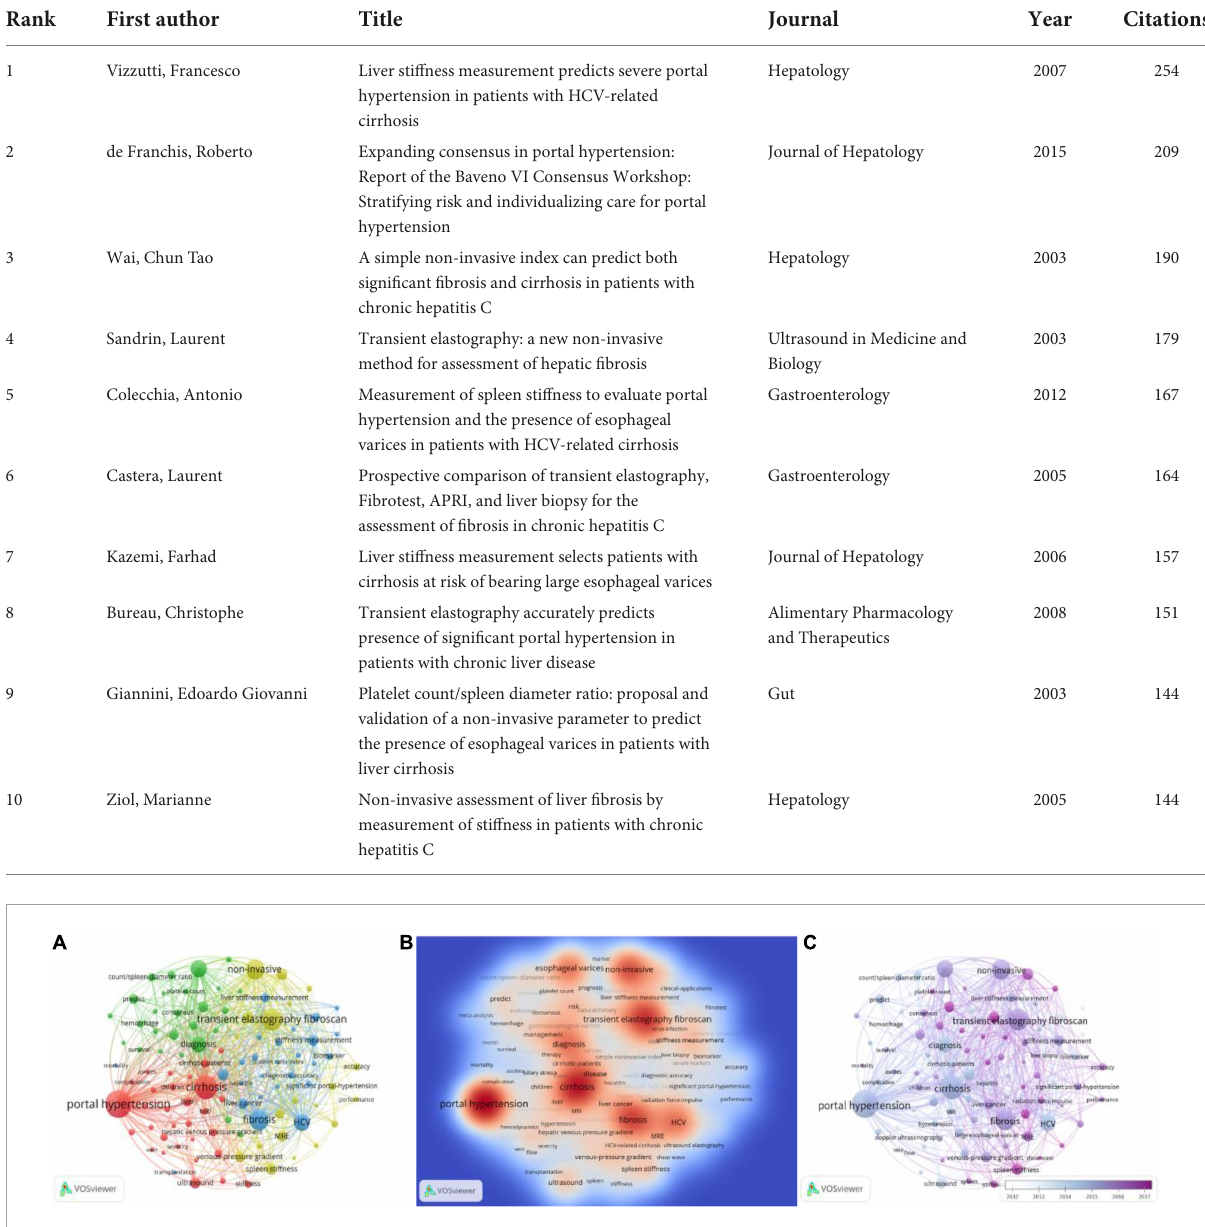
TABLE 6 The top 10 high-cited references.